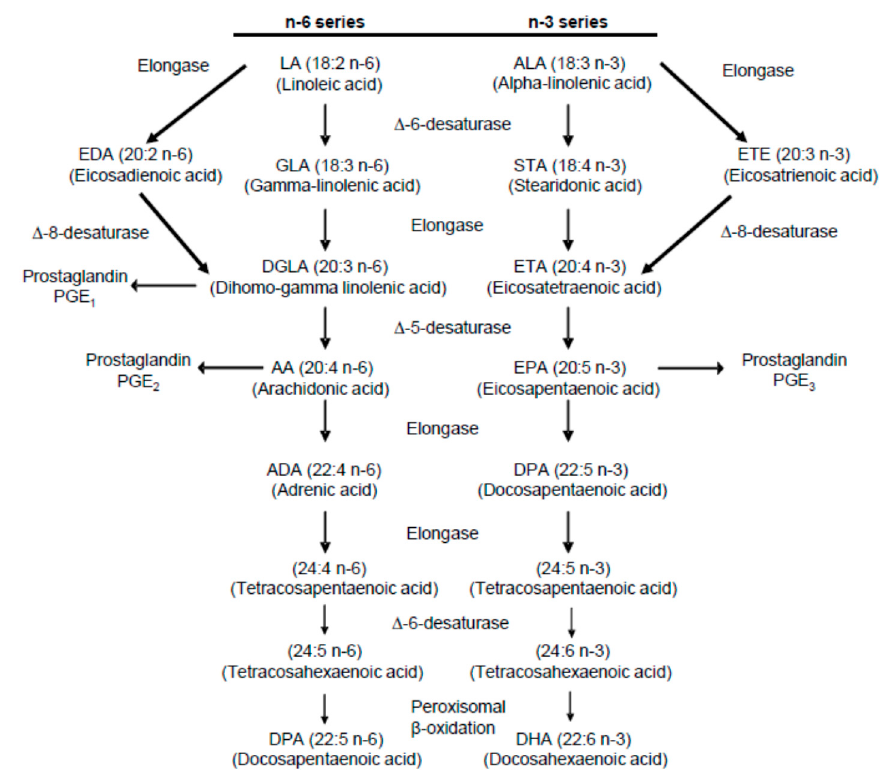
Figure 1. Summary of the metabolic pathway for n-6 and n-3 polyunsaturated fatty acids [15].